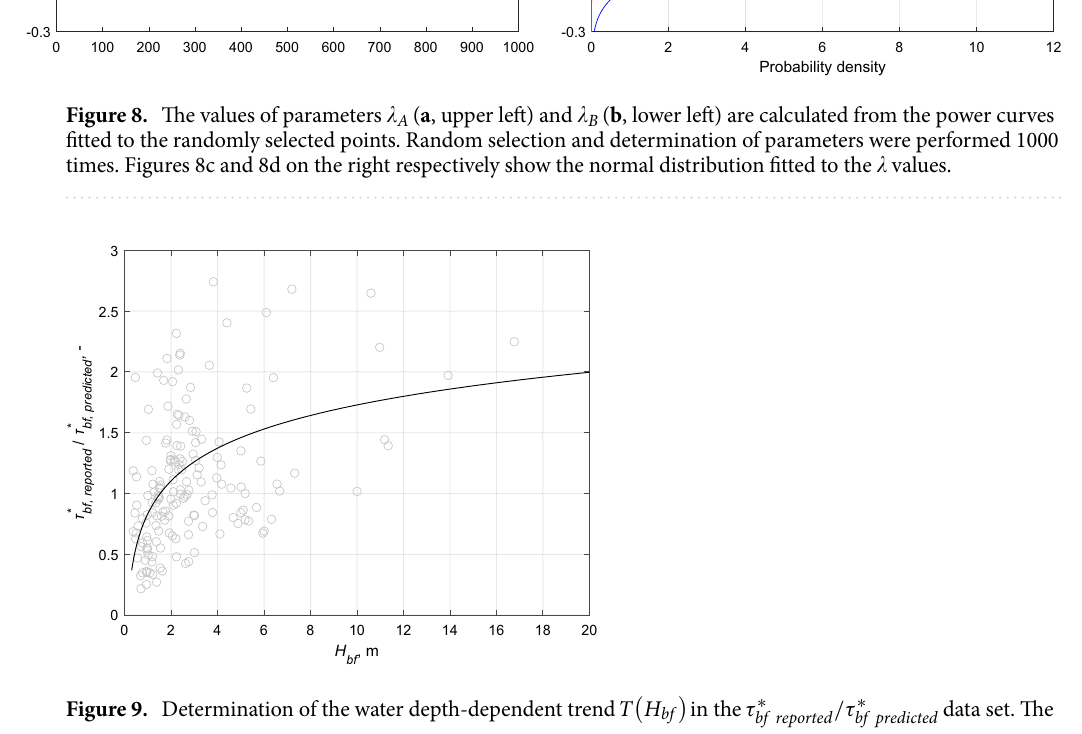
Figure 9. Determination of the water depth-dependent trend T solid line shows the prediction of τ ∗ bf reported /τ ∗ bf predicted as the function of H bf . See Eq. (12) Using all of our points, we found a logarithmic trend for the discrepancy ratio a function of bankfull depth H bf for all the points. The value of each point ( Y ) can be partitioned into a bankfull water depth-dependent trend ( T ) and a scatter ( S ) term, in accordance with the following form: